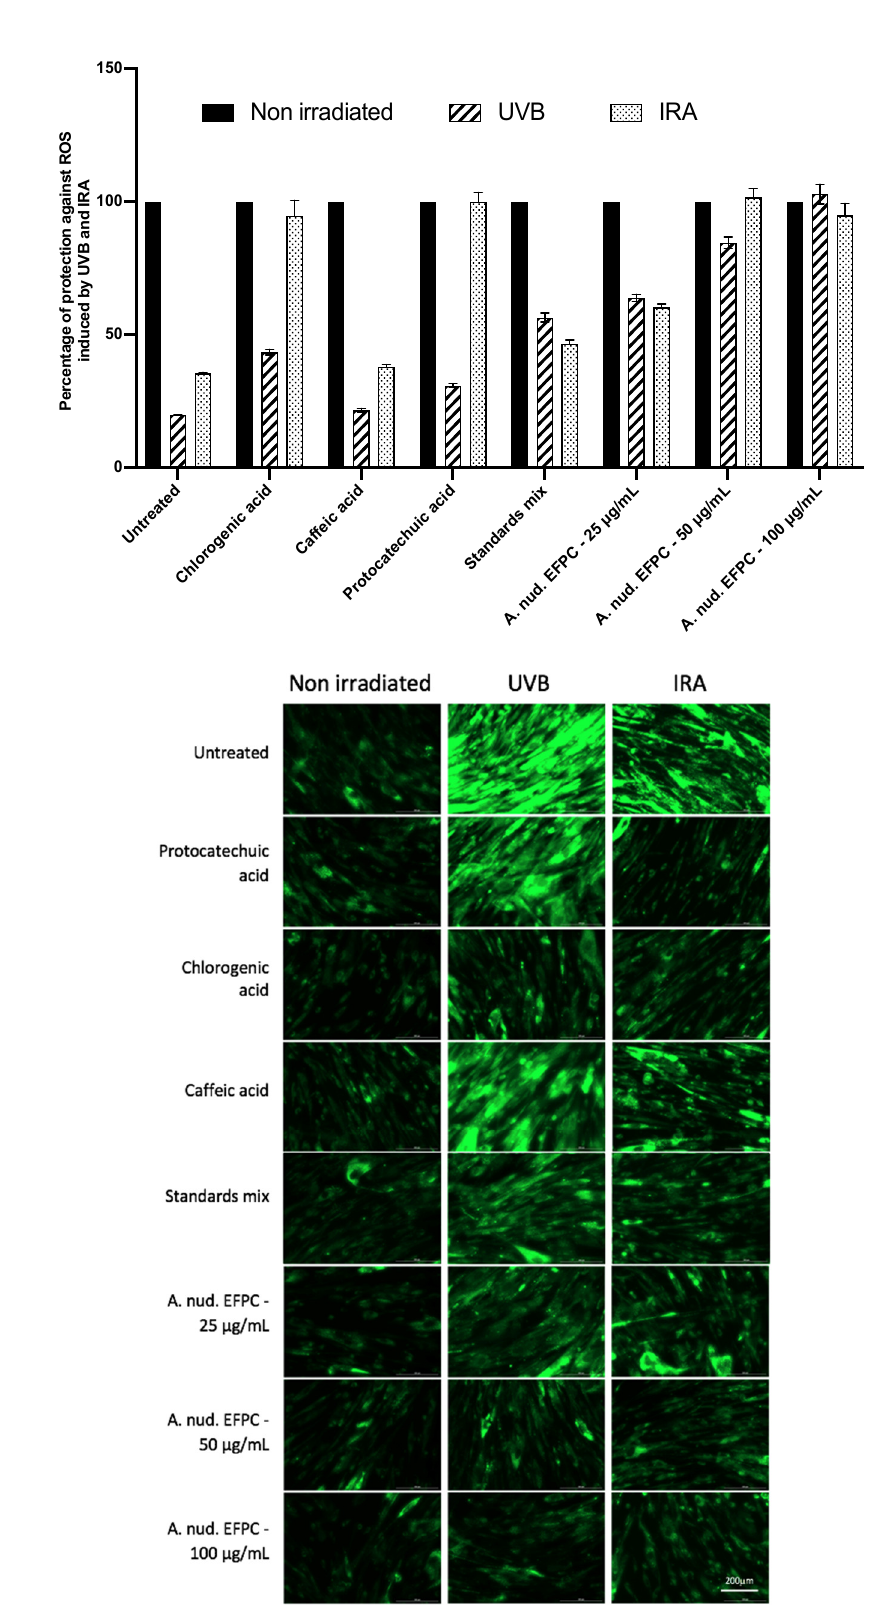
Figure 3. Evaluation of protective effect of FEPC and positive controls ( A ) following UV-B and IR-A irradiation (4700 mJ/cm 2 ) on human skin fibroblast (WS-1). Inhibition of DHR-123 fluorescence ( B ) of irradiated-cells treated or not with FEPC, protocatechuic acid, chlorogenic acid and caffeic acid analysed by Image J software. This result is representative of three independent experiments.